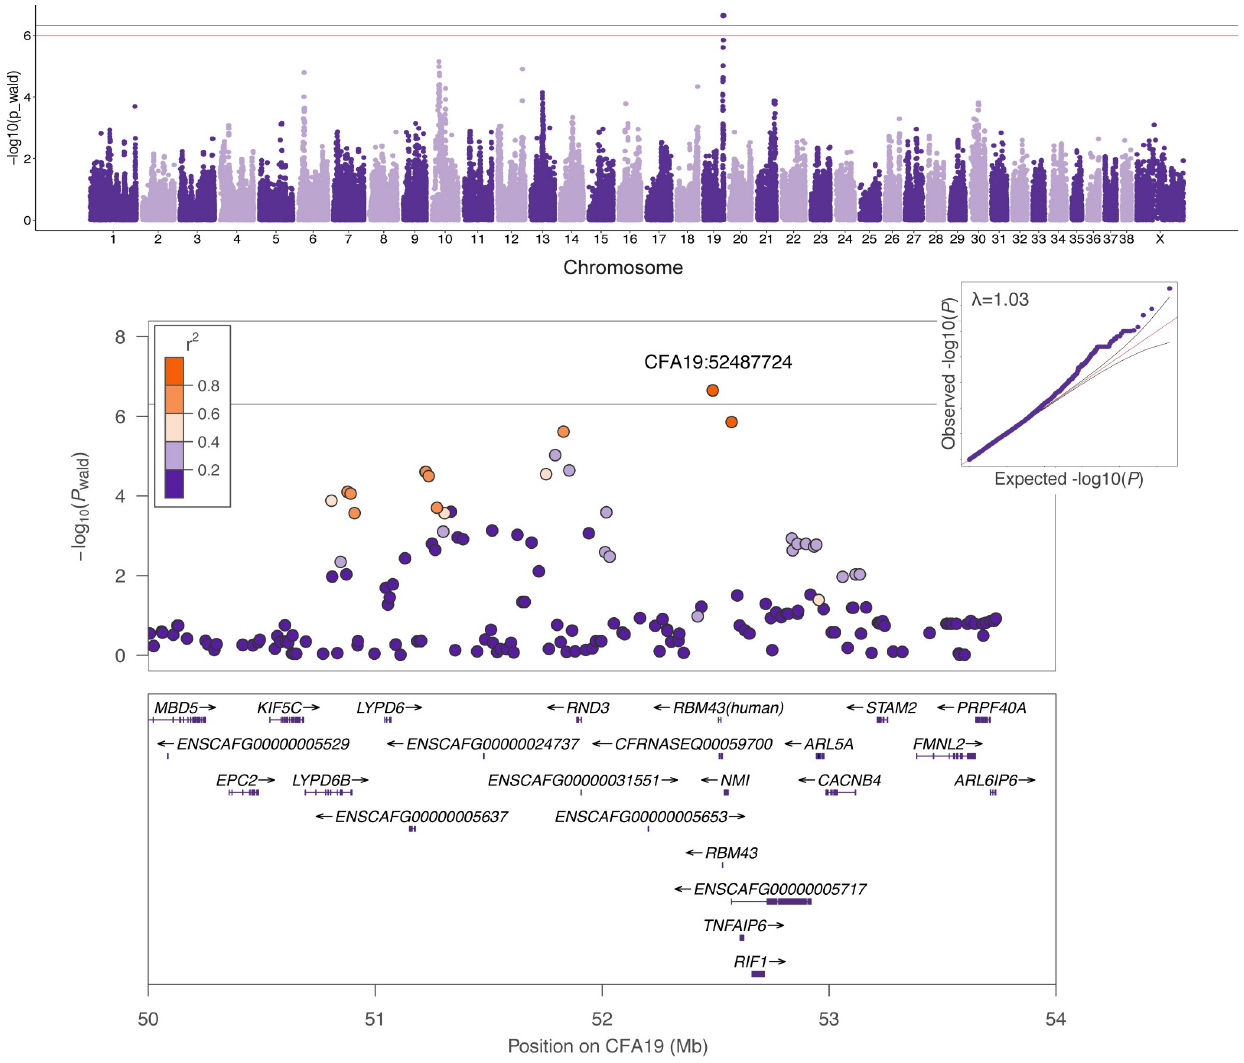
Fig 3. Genome-wide association study results for 94 histiocytic sarcoma FCR cases vs. 43 controls. All cases and controls were heterozygous for the CFA5 risk haplotype. Manhattan plot of -log 10 P -values (y-axis) for 107102 SNPs by chromosome position in CanFam3.1 (x-axis) is shown at the top. The Bonferroni and 5% permutations thresholds are plotted as gray and red lines, respectively. QQ plot with genomic inflation factor ( λ ) and regional Manhattan plot of CFA19 locus, showing pairwise LD (r 2 ) relative to the lead SNP are below with genes in the region plotted at the bottom.